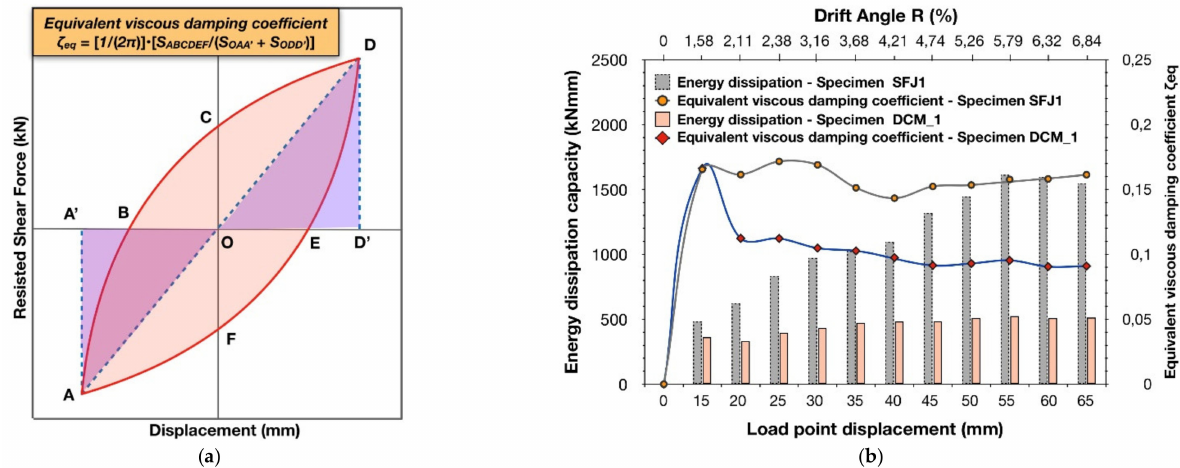
Figure 15. Plots of ( a ) equivalent viscous damping coefficient; ( b ) energy dissipation capacity versus displacement, and equivalent viscous damping coefficient versus displacement of subassemblages SFJ1 and